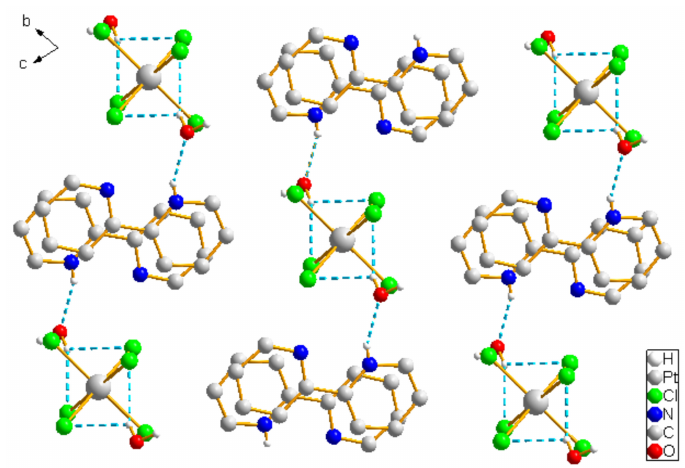
Figure 4. Hydrogen-bonded motifs and the packing graphic for complex 2 . Hydrogen bonds are shown as dashed lines.